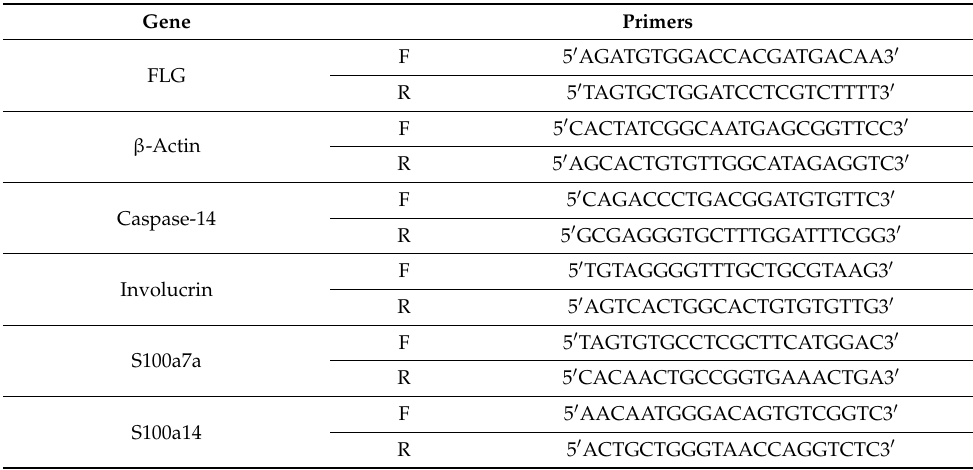
Table 2. Primers used for